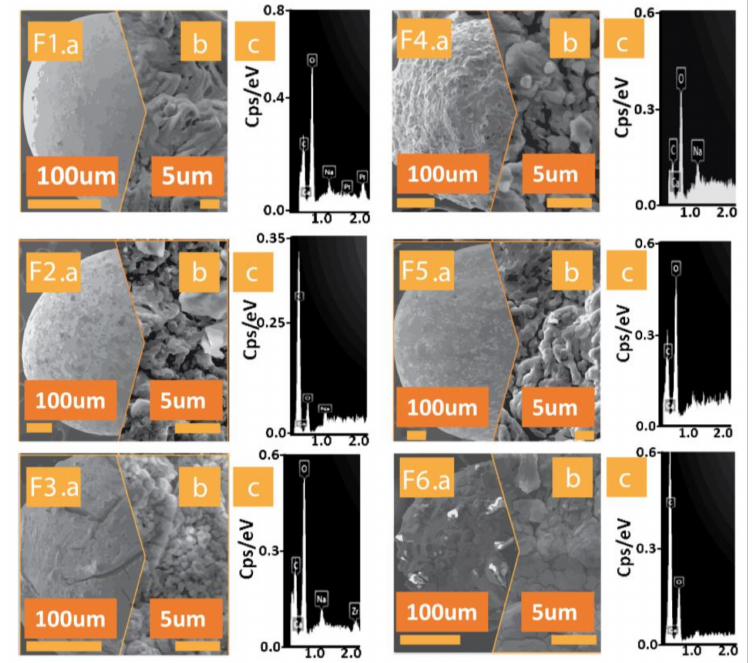
Figure 1. Scanning electron micrographs and surface morphology of formulations from F1 to F6 and corresponding surface morphology (labelled ( a ) for scale of 100 µ m and ( b ) for scale of 5 µ m)., and en- ergy dispersive x-ray from F1 to F6 (labelled as ( c ) for each) showing surface elemental